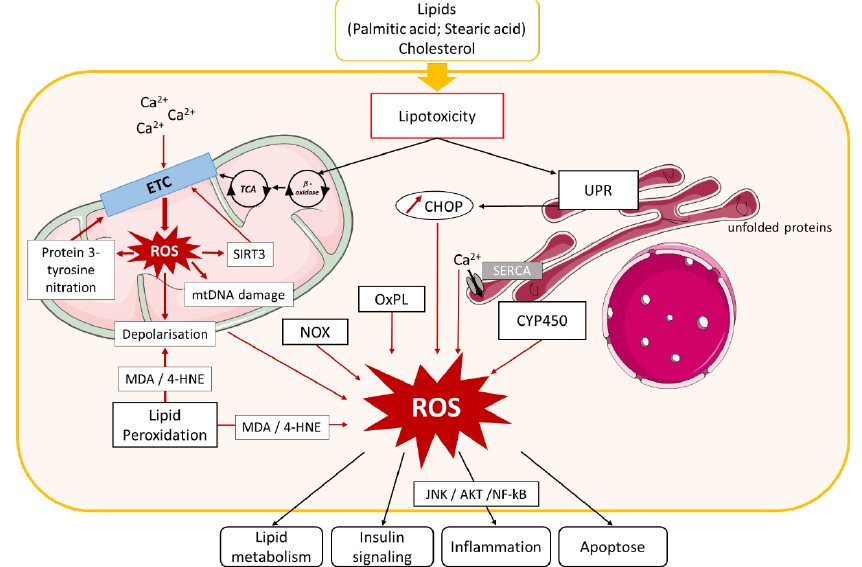
Figure 2. Role of oxidative stress in NAFLD. Lipid and cholesterol accumulation in hepatocytes causes lipotoxicity, resulting in activation of different pathways involved in oxidative stress. Lipid entry and alteration of mitochondrial Ca 2 + homeostasis cause electron transport chain (ETC) dysfunction that leads to mitochondrial reactive oxygen species (ROS) production, which in turn induces Sirtuin (SIRT)3 expression, protein 3-tyrosine nitration, mitochondrial DNA damage, and membrane depolarization. SIRT3 and protein nitration also cause ETC dysfunction and exacerbate mitochondrial ROS production. Mitochondrial biogenesis dysfunction additionally induces ROS production. Lipotoxicity activates endoplasmic reticulum (ER) stress, leading to ROS production by (i) unfolded protein response (UPR) activation, which stimulates C / EBP homologous protein (CHOP) expression and (ii) Ca 2 + homeostasisdysfunction. ROSgenerationincytoplasmisinducedbynicotinamideadeninedinucleotide phosphate (NADPH) oxidase (NOX) enzyme activation, oxidized phospholipids (OxPL), several cytochrome p450 enzymes (CYP450), and lipid peroxidation. ROS accumulation in hepatocytes leads to impairment of several pathways involved in NAFLD development, such as lipid metabolism, insulin signaling, inflammation, and apoptosis. Other abbreviations: mtDNA, mitochondrial DNA; TCA, tricarboxylic acid cycle; MDA, malondialdehyde; 4-HNE, 4-hydroxynonenal; SERCA, ER calcium pump sarco / endoplasmatic reticulum Ca 2 + -ATPase; JNK, c-Jun N-terminal kinase; NF- κ B, nuclear factor-kappa